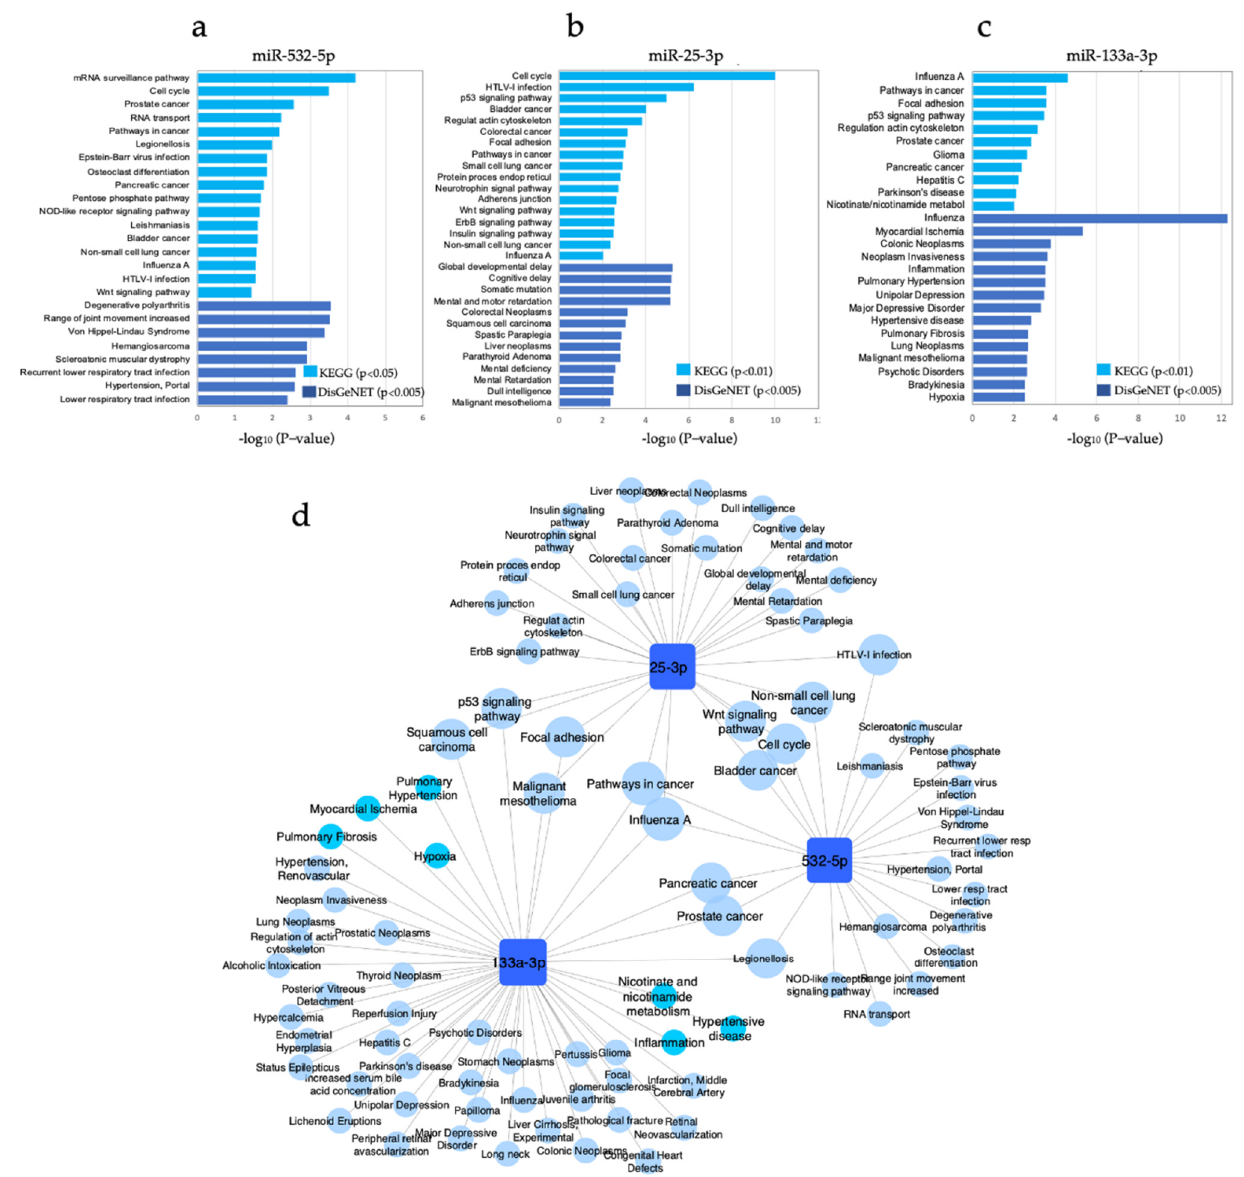
Figure 4. Pathway enrichment analysis of miR-532-5p, miR-25-3p and miR-133a-3p. ( a – c ) The figure shows the top significantly enriched pathways (KEGG, p < 0.01; and DisGeNET, p < 0.005) regulated by experimentally validated genes targeted by miR-532-5p, miR-25-3p and miR-133a-3p. ( d ) The network of the miRNAs and their significantly enriched pathways. The miRNAs are displayed as blue squares, and pathways are displayed as light blue circles. The size corresponds to the number of interactions between pathways and the miRNAs. Pathways associated with inflammation and smoking- associated diseases are highlighted with bright blue color. Cytoscape v3.1.0 was used for network visualization.